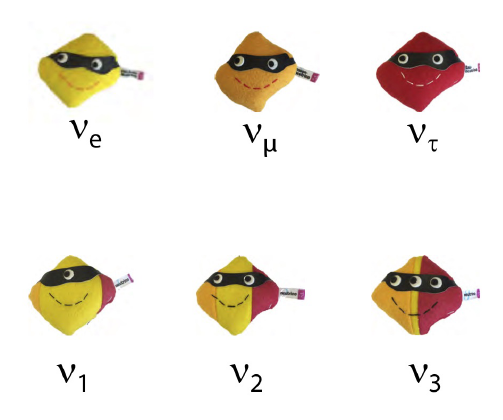
Figure 1. Illustration of the neutrino flavor and mass states. The mass states are a superposition of the flavor states. Courtesy the